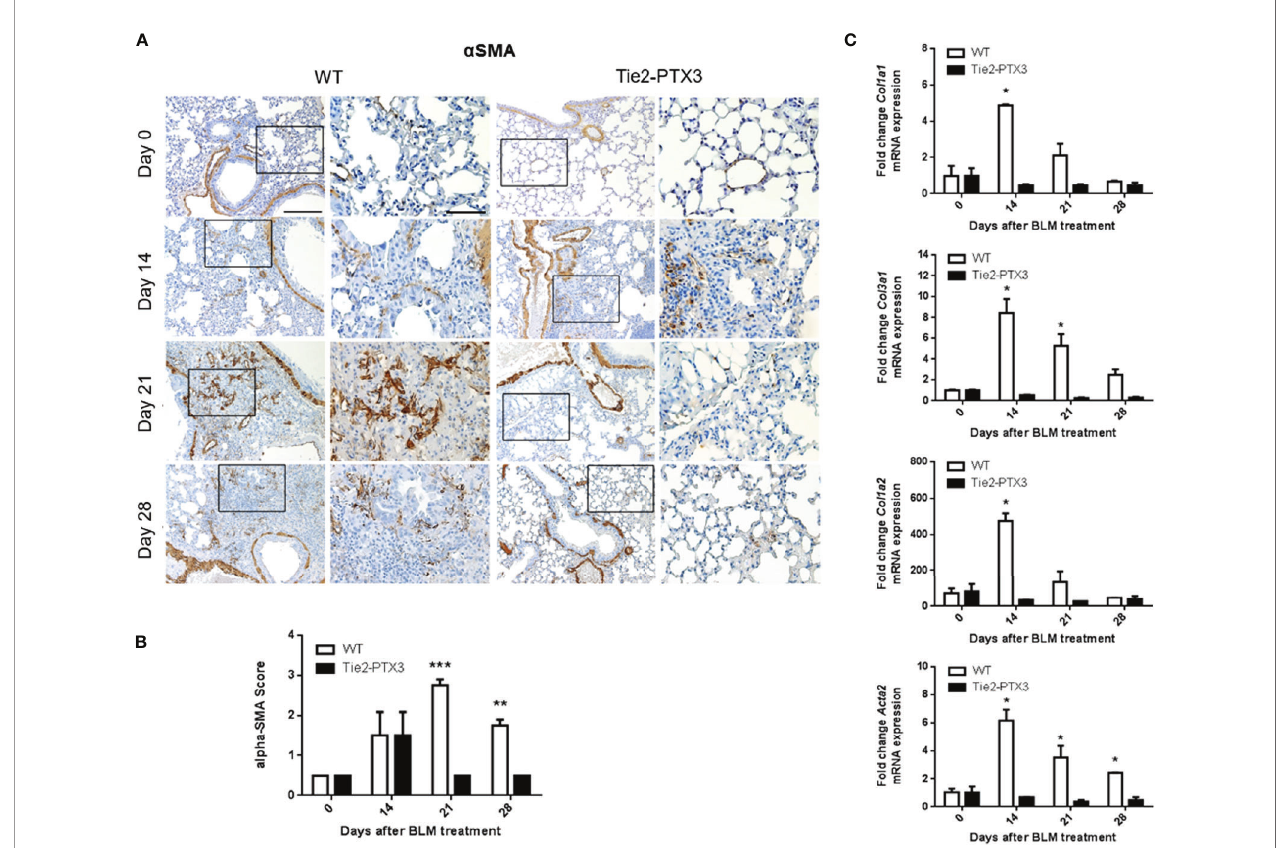
FIGURE 3 | Stromal PTX3 overexpression reduces fi broblast activation in BLM-induced lung fi brosis. (A) Immunohistochemical analysis of a SMA expression in the lungs of wild type (WT) and transgenic Tie2-PTX3 mice treated with bleomycin (BLM). For each image, the boxed area is shown at higher magni fi cation in the right panel. Scale bar = 100 µm; scale bar of magni fi ed images = 200 µm. (B) Score quanti fi cation of the a SMA immunostaining. a SMA immuno-reactivity in perivascular and peri-bronchiolar areas was excluded from the quanti fi cation. (C) qPCR analysis on lung extracts for the expression of collagen subunits and Acta2 mRNA. N = 5 – 8 mice/group; *P < 0.05, **p < 0.01, ***p <